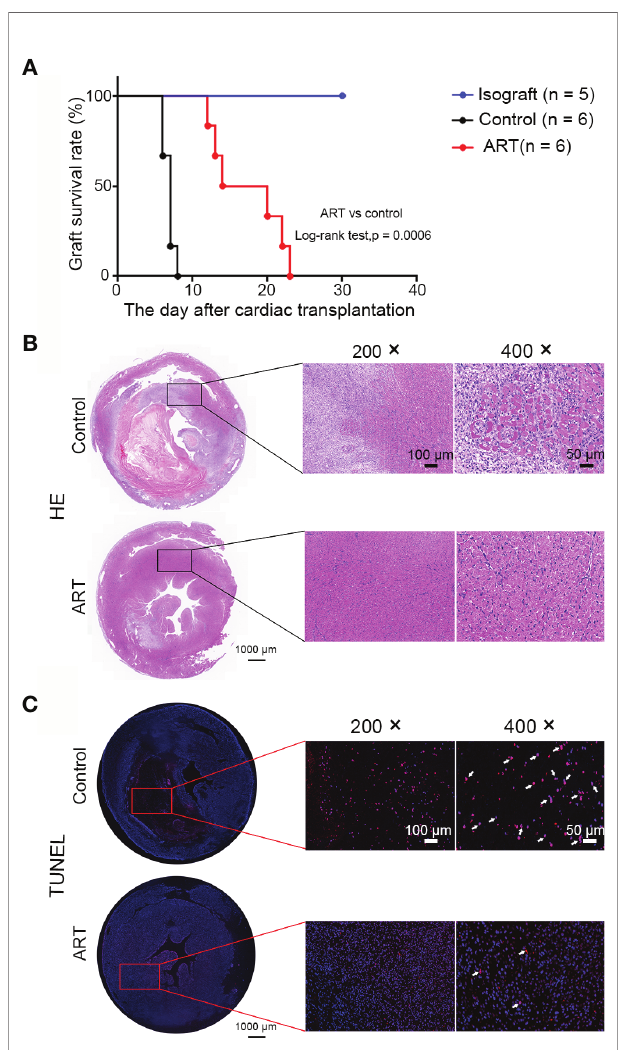
FIGURE 1 | Artemisinin (ART) reduces in fl ammatory in fl ltration, myocyte damage, and apoptosis of cells to prolong cardiac allograft survival. (A) ART signi fi cantly prolonged allograft survival compared to that in controls. (B) Histologic evaluation of cardiac allografts post-transplant. Hematoxylin and eosin staining showing interstitial vasculitis, hemorrhage, edema, and myocyte damage. (C) Representative images of heart sections showing TUNEL-positive cells (red, arrowheads indicated) in the rejection area; nuclei are stained with DAPI (blue). TUNEL, (TdT)-mediated nick end-labeling; DAPI, 4 ’